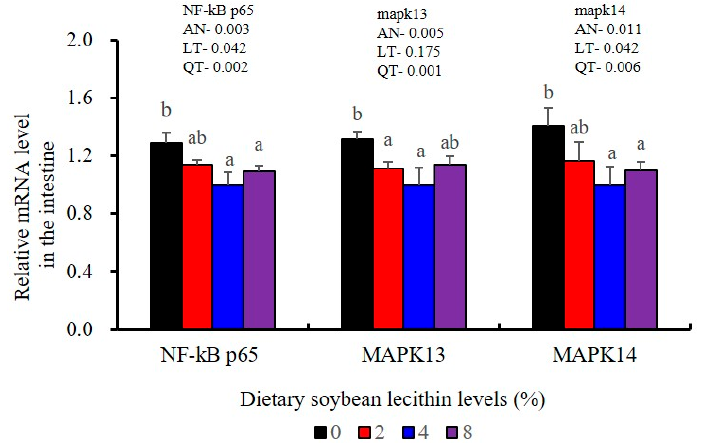
Figure 8. Effects of dietary soybean lecithin levels on relative gene expression levels of mitogen- activated protein kinase (MAPK) signal pathway in the intestine of juvenile largemouth bass. Bars with different letters indicate significant differences ( p < 0.05), while that with the same letter or no letter superscripts indicate no significant differences ( p > 0.05), AN: ANOVA, LT: linear trend, QT: quadratic trend.